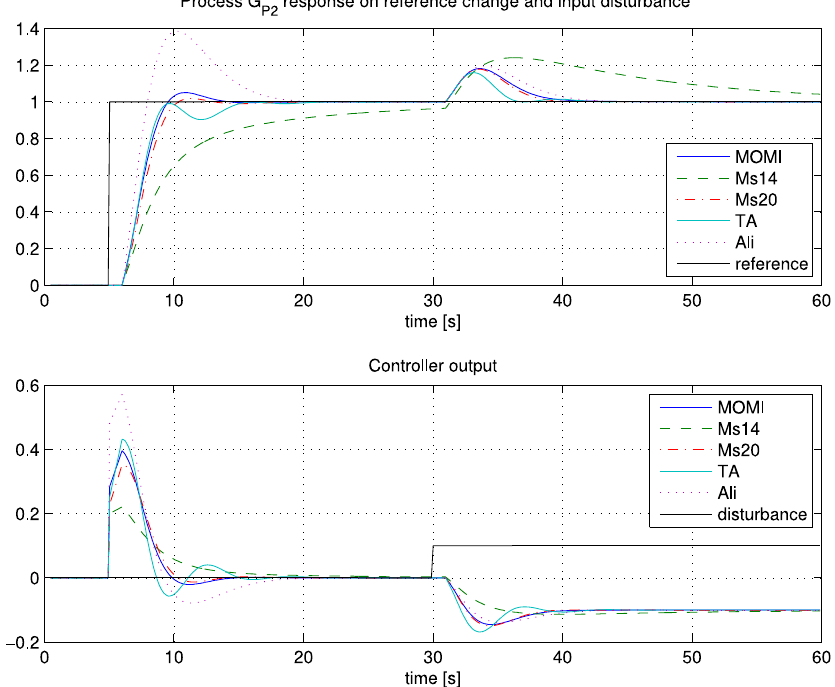
Figure 14. Closed-loop responses of G P2 process. PI controllers were tuned by MOMI, Ms14, Ms20, TA, and ALI